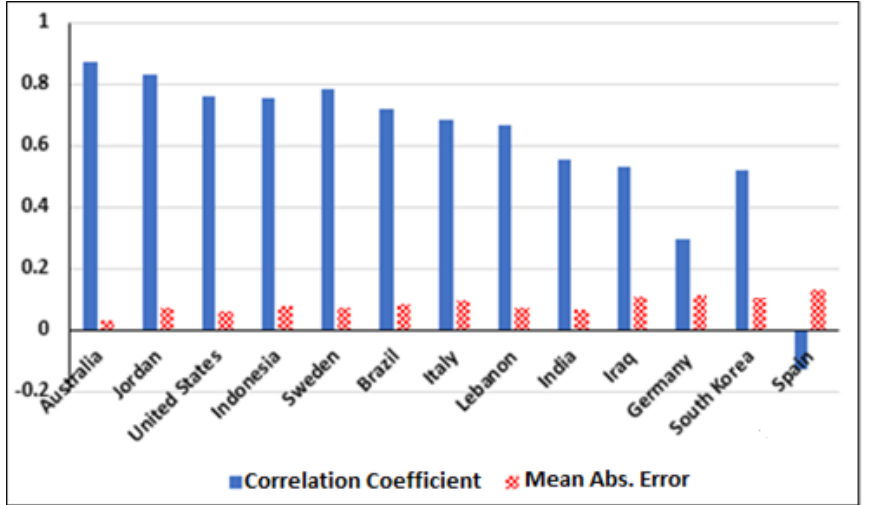
Figure 2. Correlation coefficients for 13 countries during the period between 15 February 2020 and 11 April